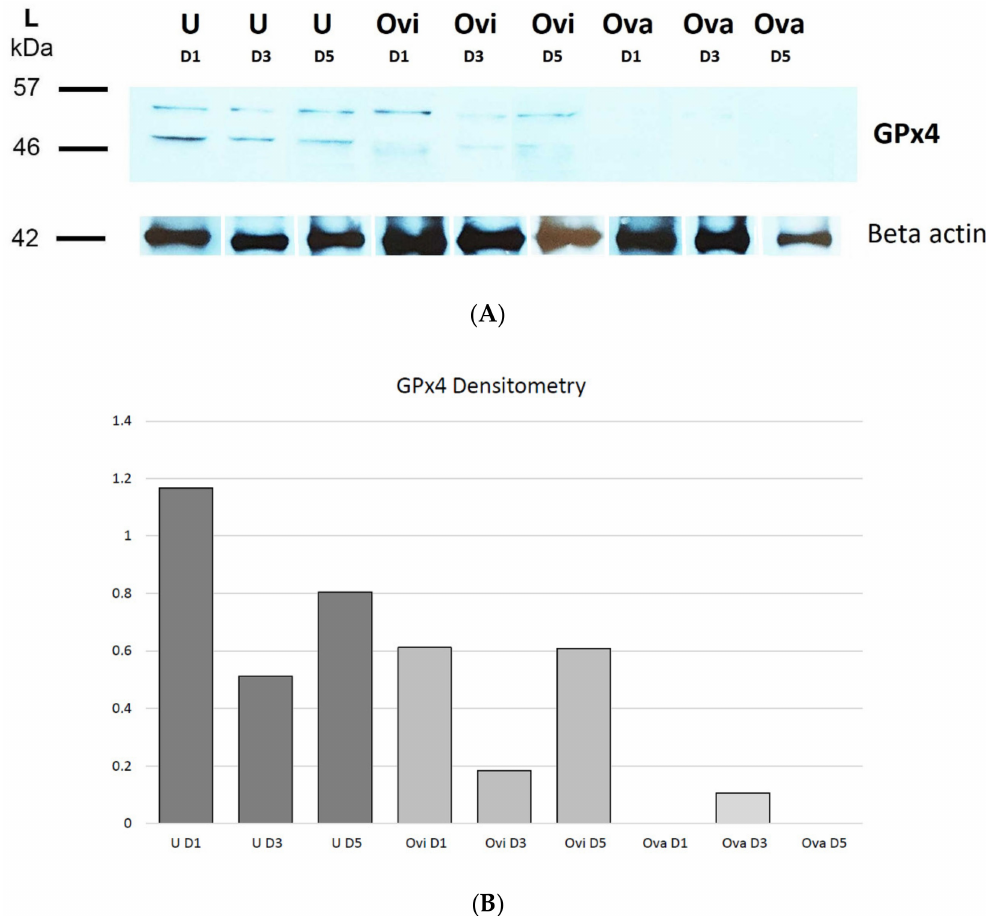
Figure 5. Western blot and densitometry analysis of the amount of GPx4 in rat female reproductive organs. ( A ) Shows Western blot analysis of GPx4. The amount of GPx4 in the rat reproductive organs compared to Beta-actin. 46 kDa could represent the mGPx4 dimer, and 57 kDa could be a coupling of mGPx4 together with nGPx4. ( B ) Shows densitometry of the female rat reproductive organs. Densitometry reveals the amounts of GPx4 in the rat reproductive organs compared to Beta-actin. Amounts of GPx4 were most abundant in the uterus on D1, but the enzyme on D1 and D5 was not detected in the ovary. U denotes uterus; Ovi is oviduct; Ova refers to the ovary; D1, D3, D5 denote the first, the third, the fifth day of pregnancy; GPx4 is glutathione peroxidase 4; mGPx4 refers to mitochondrial GPx4; nGPx4 is nuclear